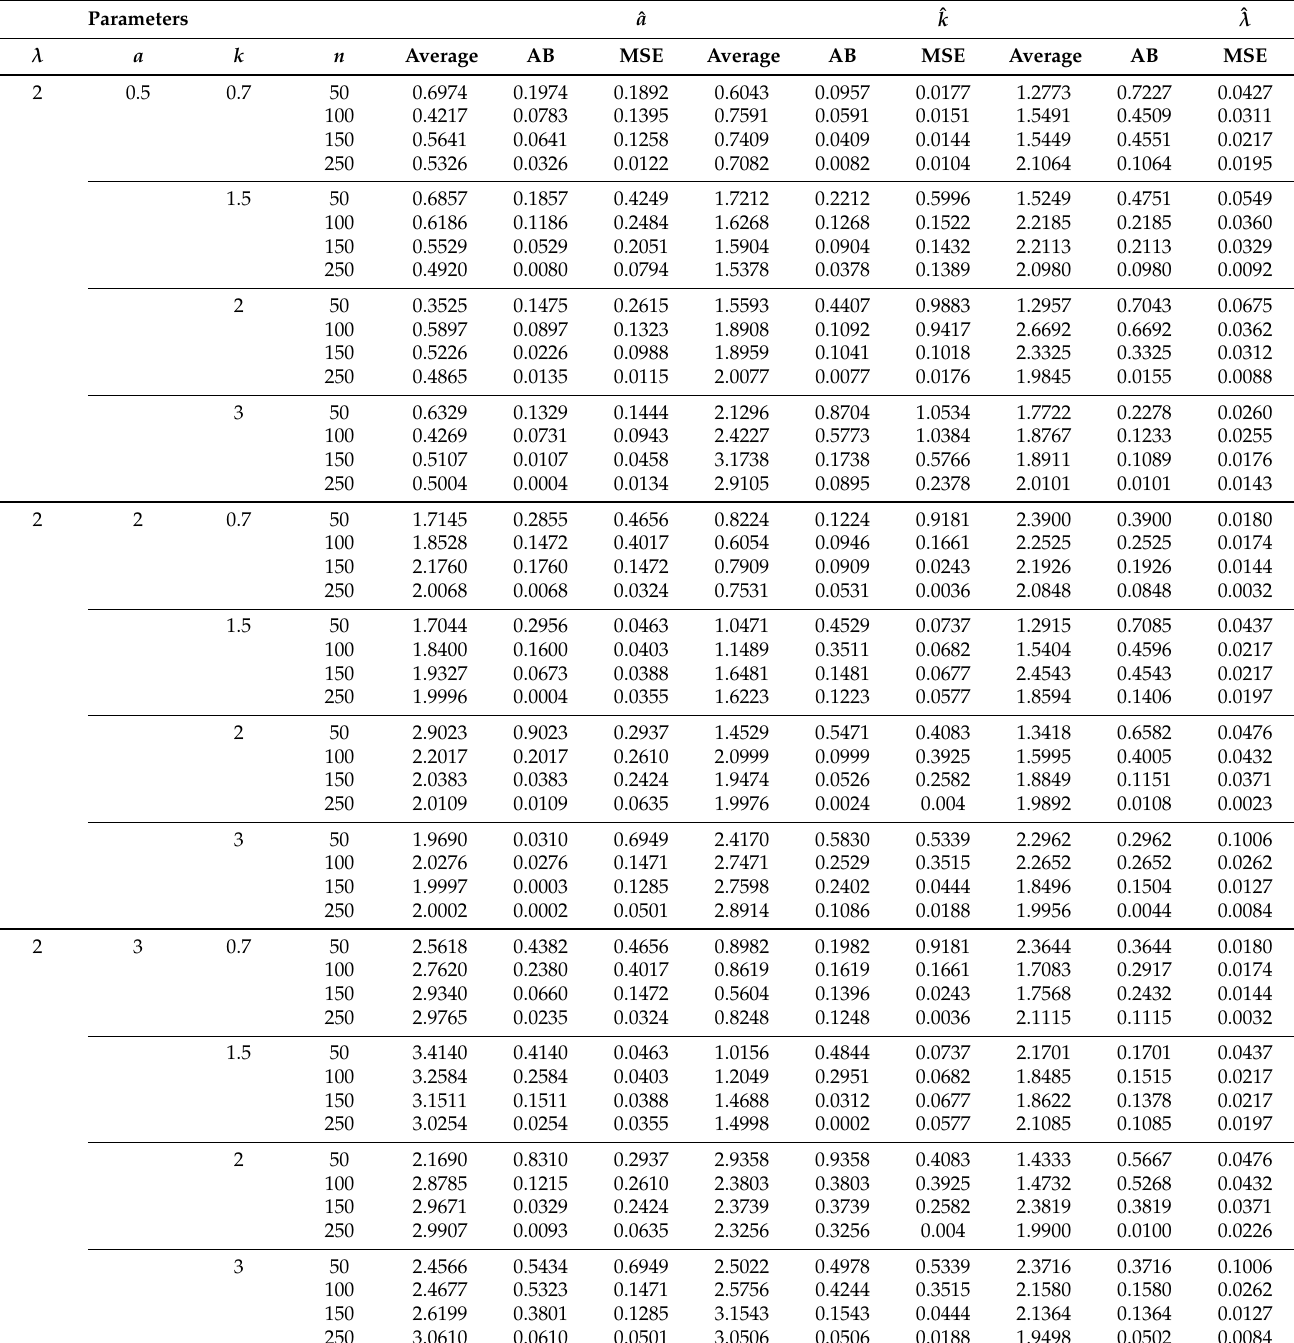
Table 2. Simulation results for the MPoW